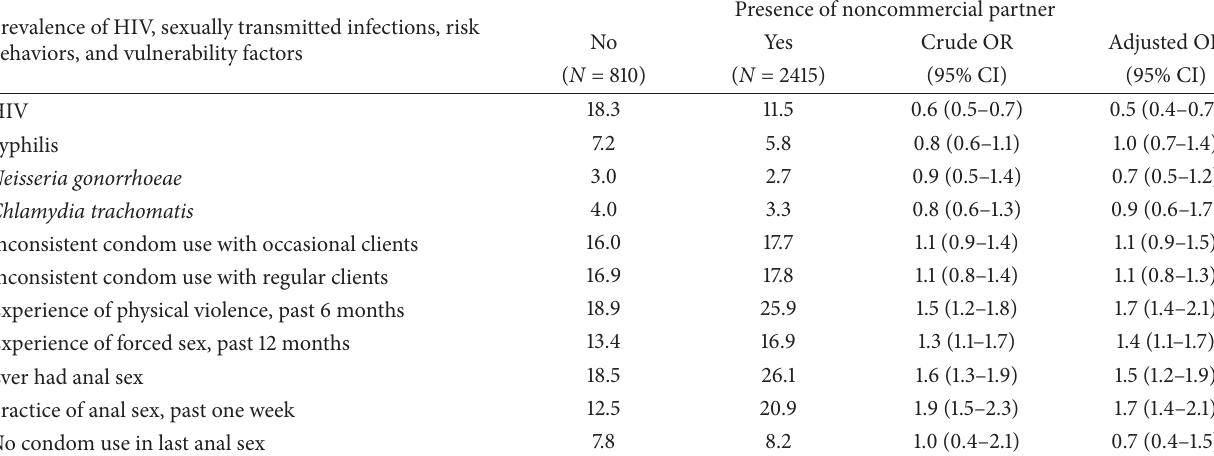
Table 2: Prevalence of HIV, sexually transmitted infections, risk behaviors, and vulnerability factors by presence of noncommercial partners among female sex workers, Andhra Pradesh, 2009 ( 𝑁 = 3225 ).